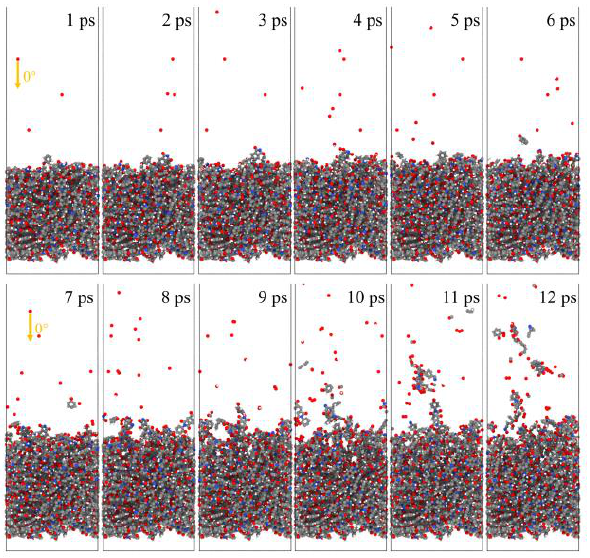
Figure 15. Evolution of the initial phase of atomic oxygen impacting Kapton material surface at 0° incidence angle.